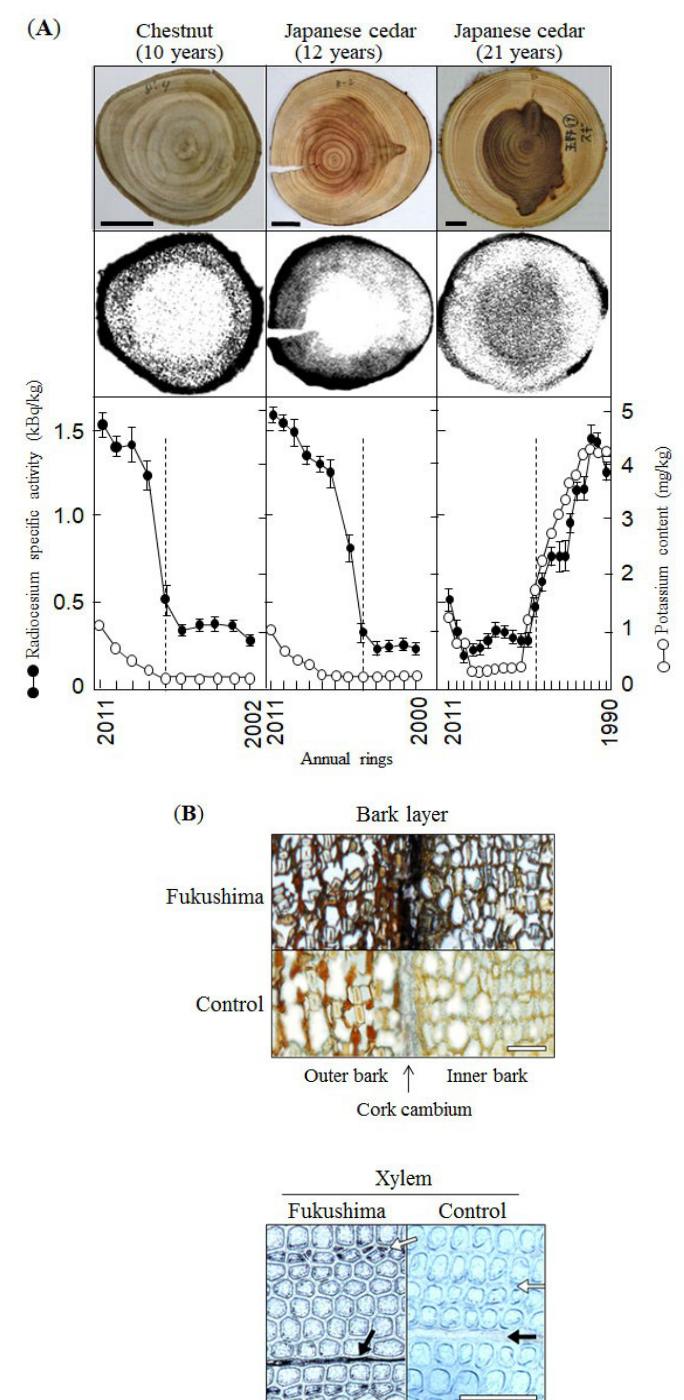
Figure 2. Transverse sections of stems with autoradiographs and levels of radiocesium and potassium. ( A ) Chestnut stem (Figure 1: area number 2), Japanese cedar stem (Figure 1: area number 2), and Japanese cedar stem (Figure 1: area number 2). Radiocesium ( 134 Cs and 137 Cs) and potassium levels were determined in 2011 wood from the left side of each ring to the pith, from which the vascular cambium zone was removed. Dotted lines show the intermediate wood between the sapwood and heartwood. Individual values represent the mean ± SD of three independent measurements. Bars = 2 cm. ( B ) Transverse sections of the bark layer and xylem of a Japanese cedar stem from the forest, one year after the nuclear accident (upper) and a control section (lower). In xylem, the black arrow shows ray cells, and the white arrow shows the narrow tips of the tracheids. Bars = 100 μm.